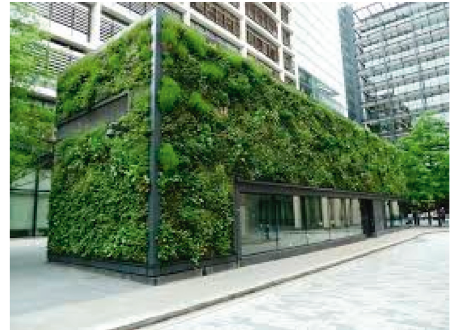
Figure 3: Example of green